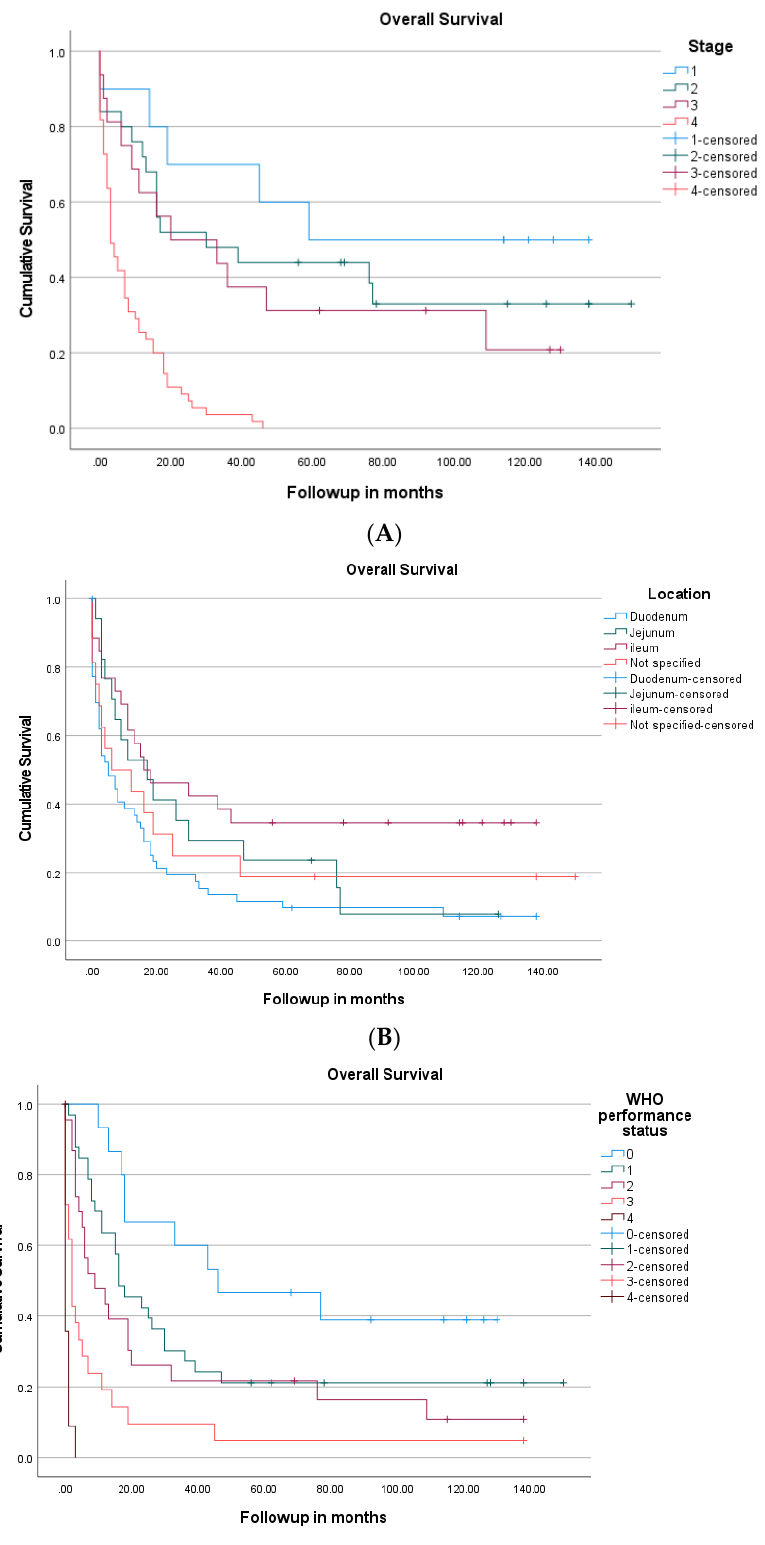
Figure 2. Kaplan – Meier survival curves of patients with small intestine cancer in relation to stage ( A ), location ( B ), and WHO performance status ( C ).